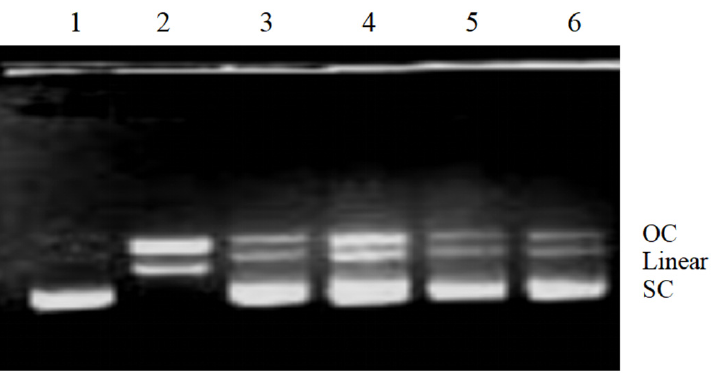
Figure 5. Electrophoretic analysis of DNA breaks generated by the Fenton reaction on agarose gels. Lane 1, pBR322 DNA; Lane 2, DNA damage control (DNA treated with FeSO 4 and H 2 O 2 ); lanes 3–4 and 5–6, DNA treated with FeSO 4 and H 2 O 2 in the presence of phenolic compounds (0.15 mg/mL and 0.3 mg/mL) from V. davidii Foex canes and stems, respectively.